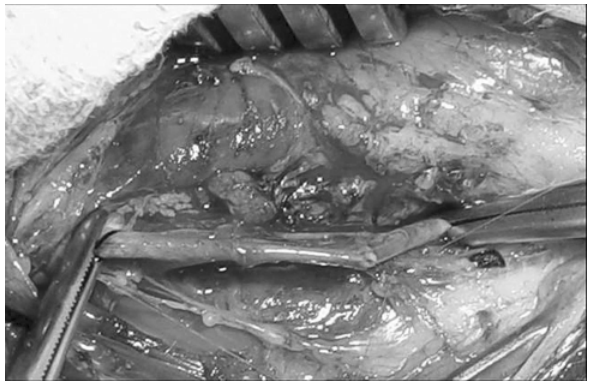
Fig. 1 - Aspecto final da anastomose